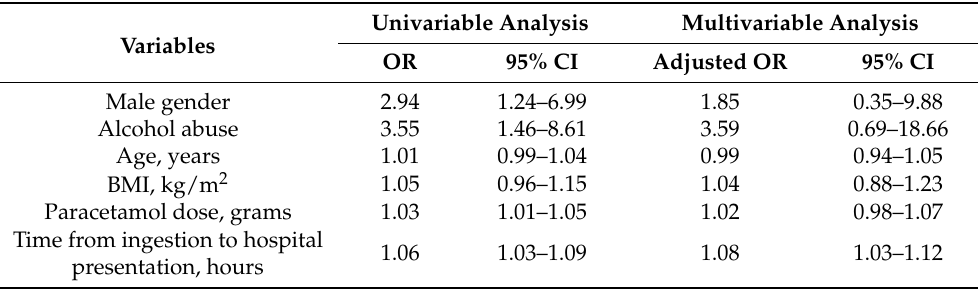
Table 2. Univariable and multivariable analysis of risk factors for hepatotoxicity during hospitaliza- tion after paracetamol overdose. Univariable Analysis Multivariable Variables